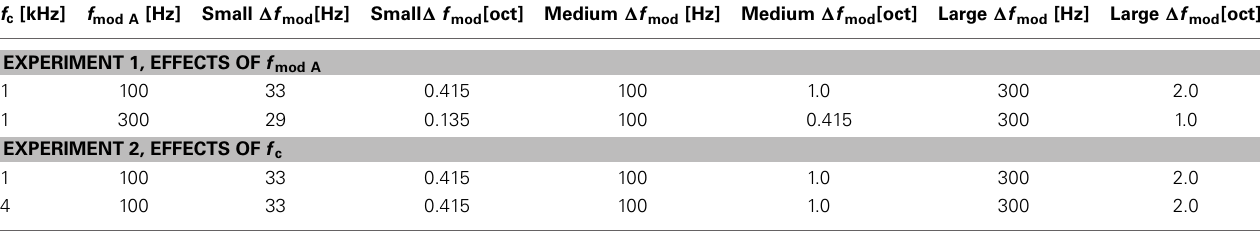
Table 1 | Stimulus conditions for Experiment 1 and Experiment